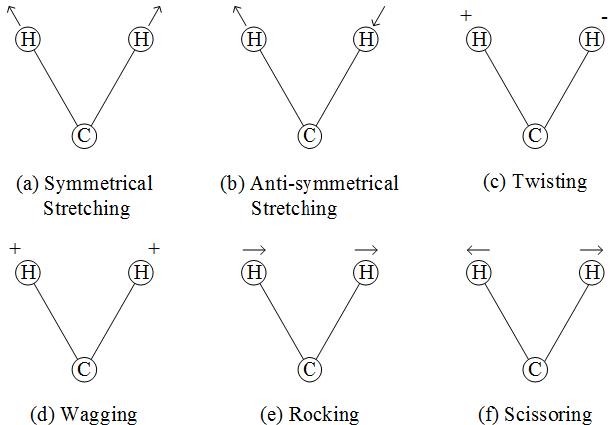
Figure 3. Vibrations in diatomic molecules [17]. Reproduced with permission from A. Nawrocka, Advances in Agrophysical Research, Published by IntechOpen, 2013.